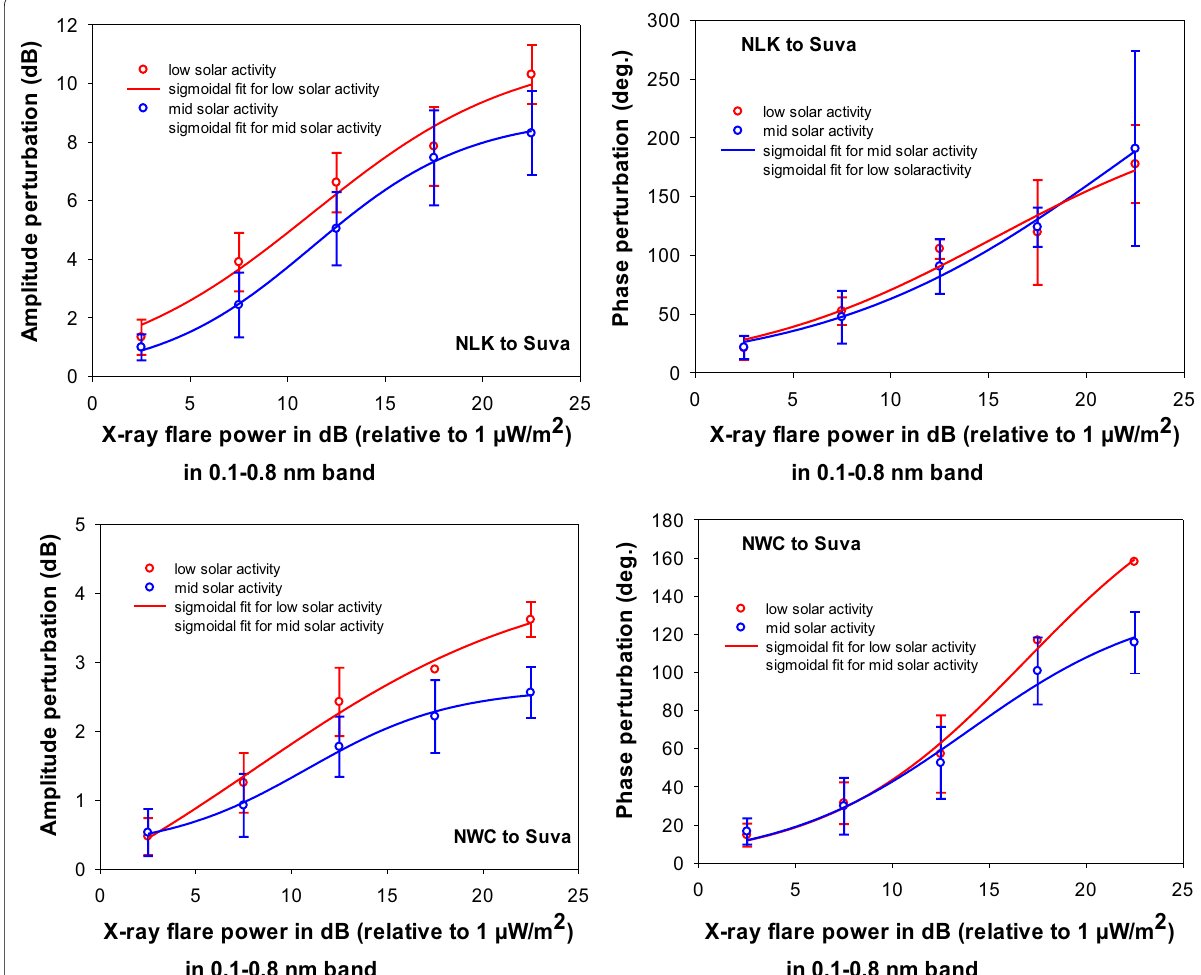
Fig. 8 Average VLF amplitude and phase perturbations of selected flare power bins for NLK and NWC as functions of solar flare X-ray flux measured in dB relative to 1 µW/m 2 in the 0.1–0.8 nm band, for low-solar activity conditions (red points and corresponding red best-fit curves) and moderate- solar activity conditions (blue points and corresponding blue best-fit